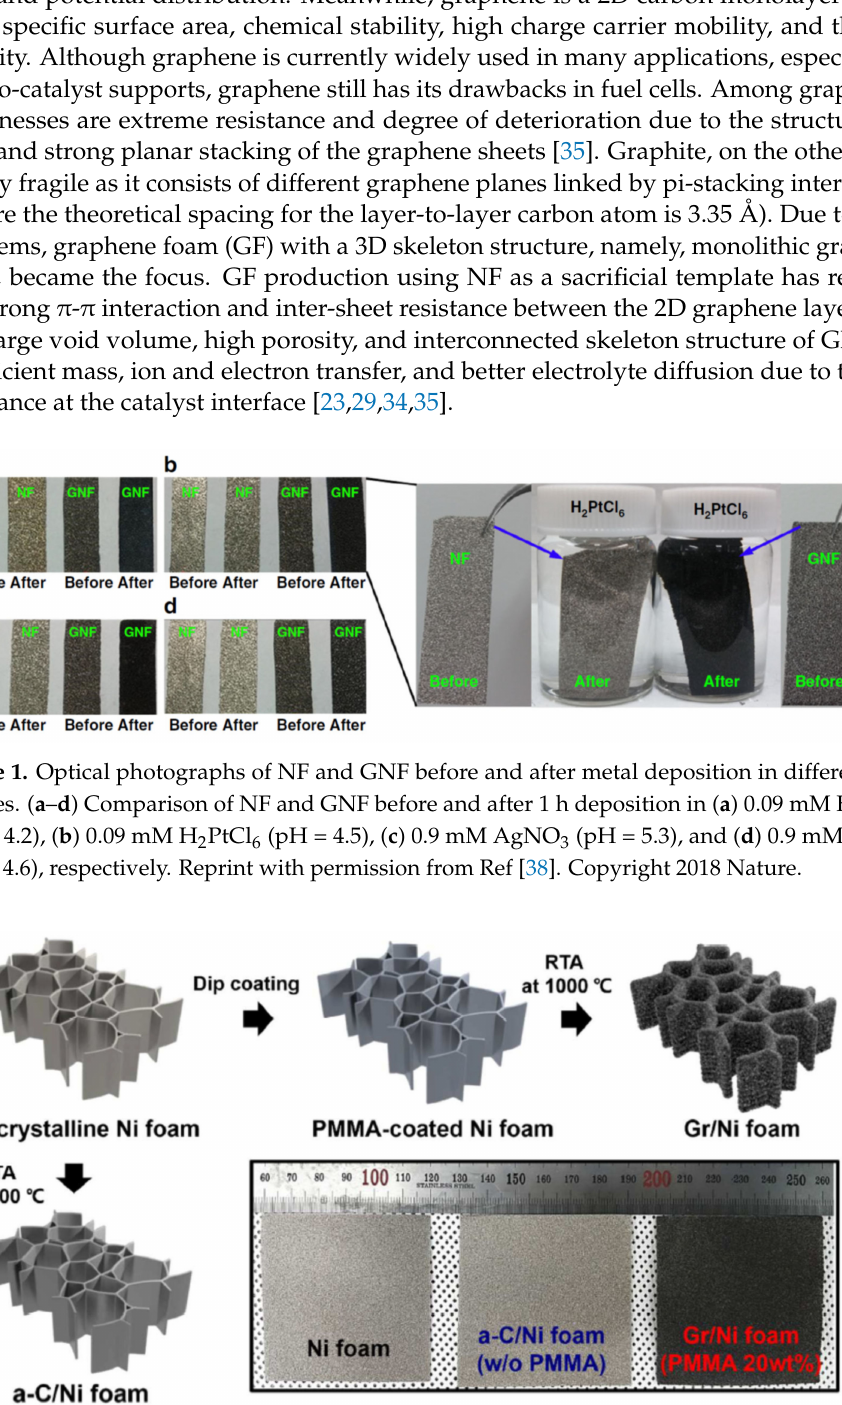
Figure 2. Schematic of the synthesis of a graphene film on Ni foam using the RTA process. In- set is photographs of a 6 × 6 cm 2 Ni foam sample before and after the growth of C-based films with/without the use of PMMA. Reprinted with permission from Ref [39]. Copyright 2018 Royal Society of